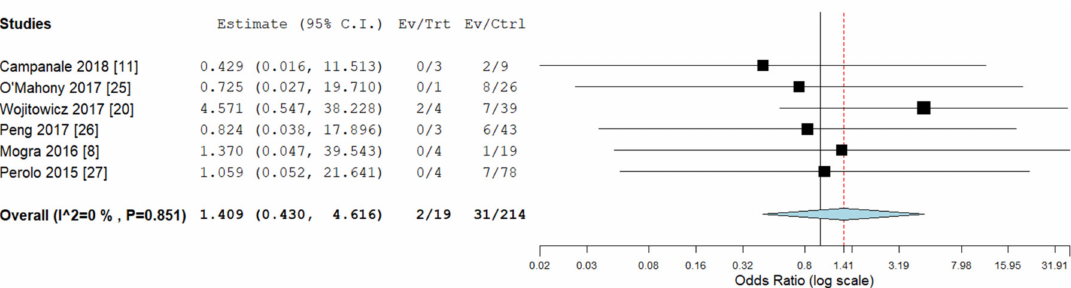
Figure 7. Pooled odd ratio (OR) for extracardiac abnormalities in right aortic arch with concomitant right ductal arch and right aortic arch with concomitant left ductal arch. (black vertical line: OR = 1, red dashed line = estimated pooled OR in the present analysis). Iˆ2: I 2 of Higgins.